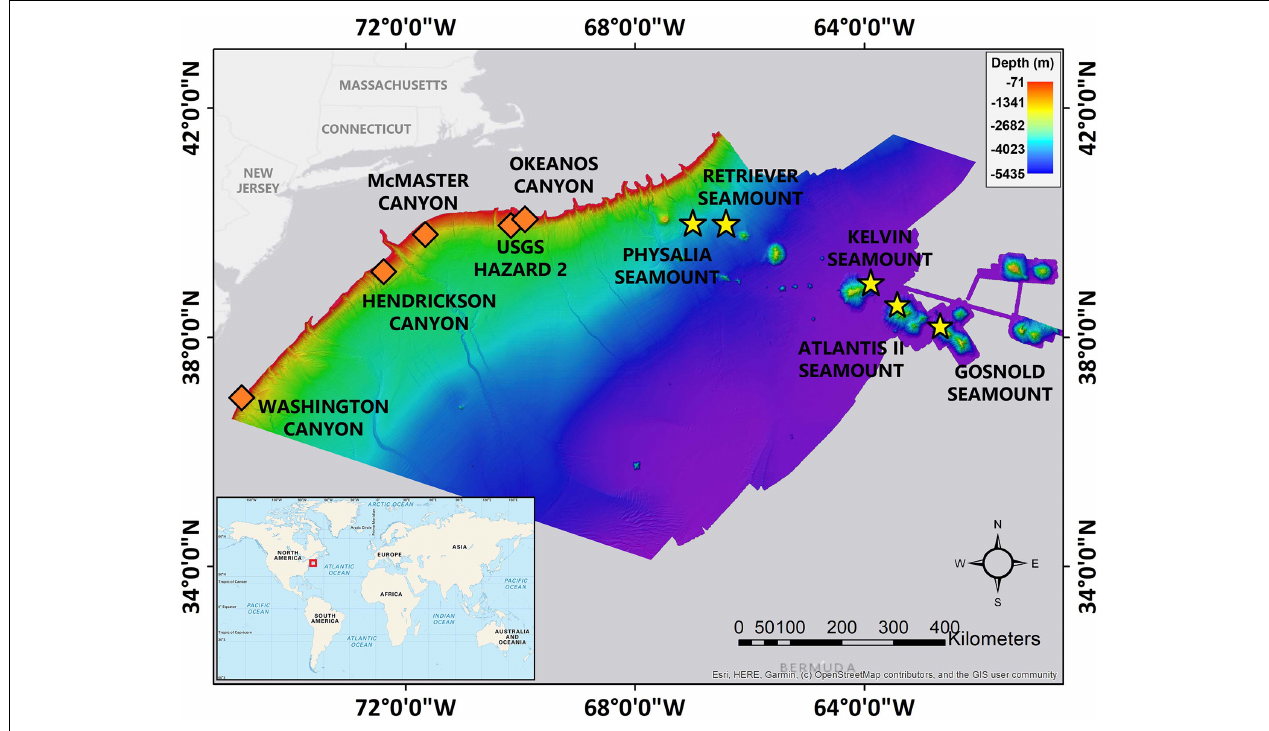
FIGURE 1 | Location of study sites along the Northwest Atlantic continental margin and New England Seamount Chain. The canyon sites are marked with the orange diamonds and the seamount sites are marked with the yellow stars. Figure modified from Dijkstra et al.